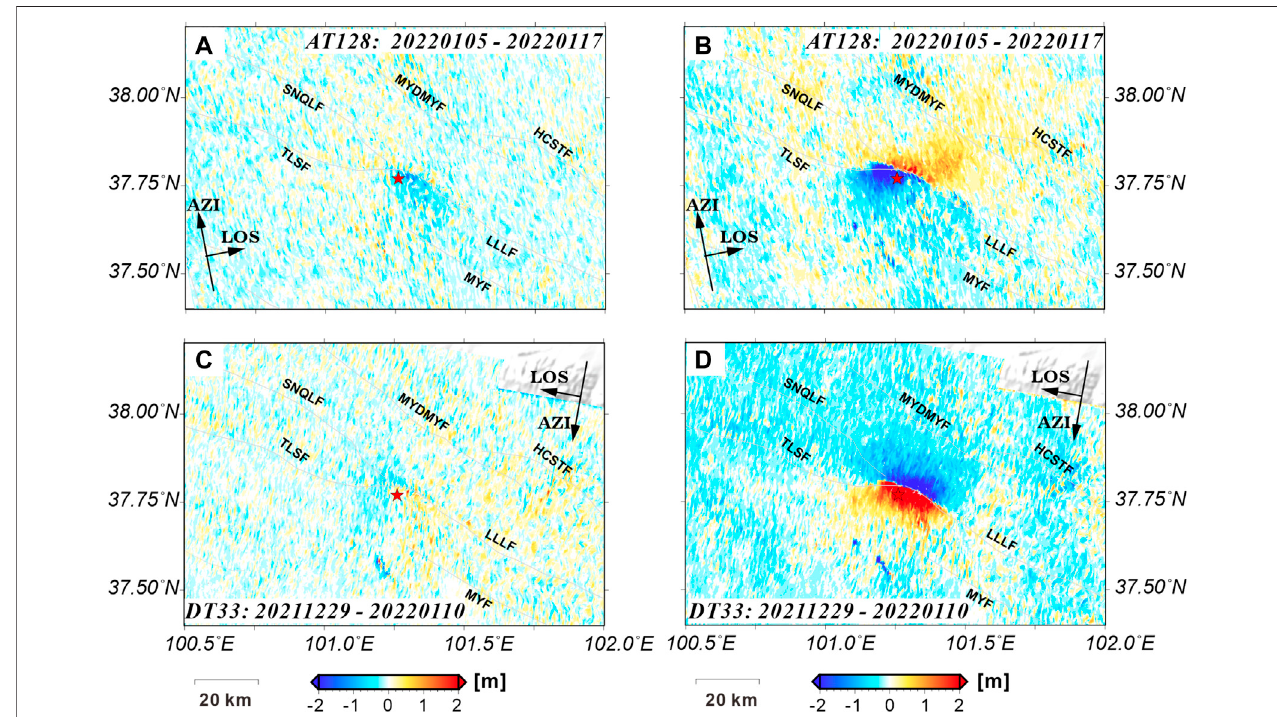
FIGURE4| TheresultsofthePixel-Trackingmethodfortheascendinganddescendingorbitamplitudes. (A,C) aretherangeoffsetoftheT128ascendingorbitand the T33 descending orbit, respectively, and the positive and negative values indicate the decreasing and increasing of the horizontal surface displacement along the distance direction from the satellite and to the target point (the range direction); (B,D) are the azimuth offset of the T128 ascending orbit and the T33 descending orbit, respectively, and the positive and negative values represent the forward and backward displacement ofthe horizontal displacement along the fl ight direction ofthe satellite, respectively. The red star indicates the epicenter. Black arrows indicate satellite fl ight direction (AZI) and right-looking observation direction (LOS).